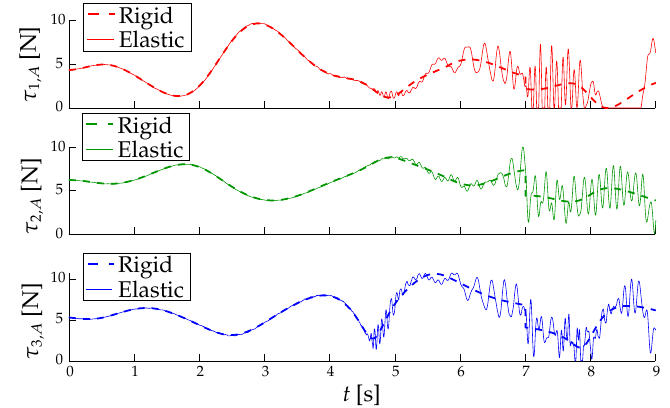
Figure 6. Plots of the cable tensions over time, with the inextensible model (dashed line) and elastic model (continuous).